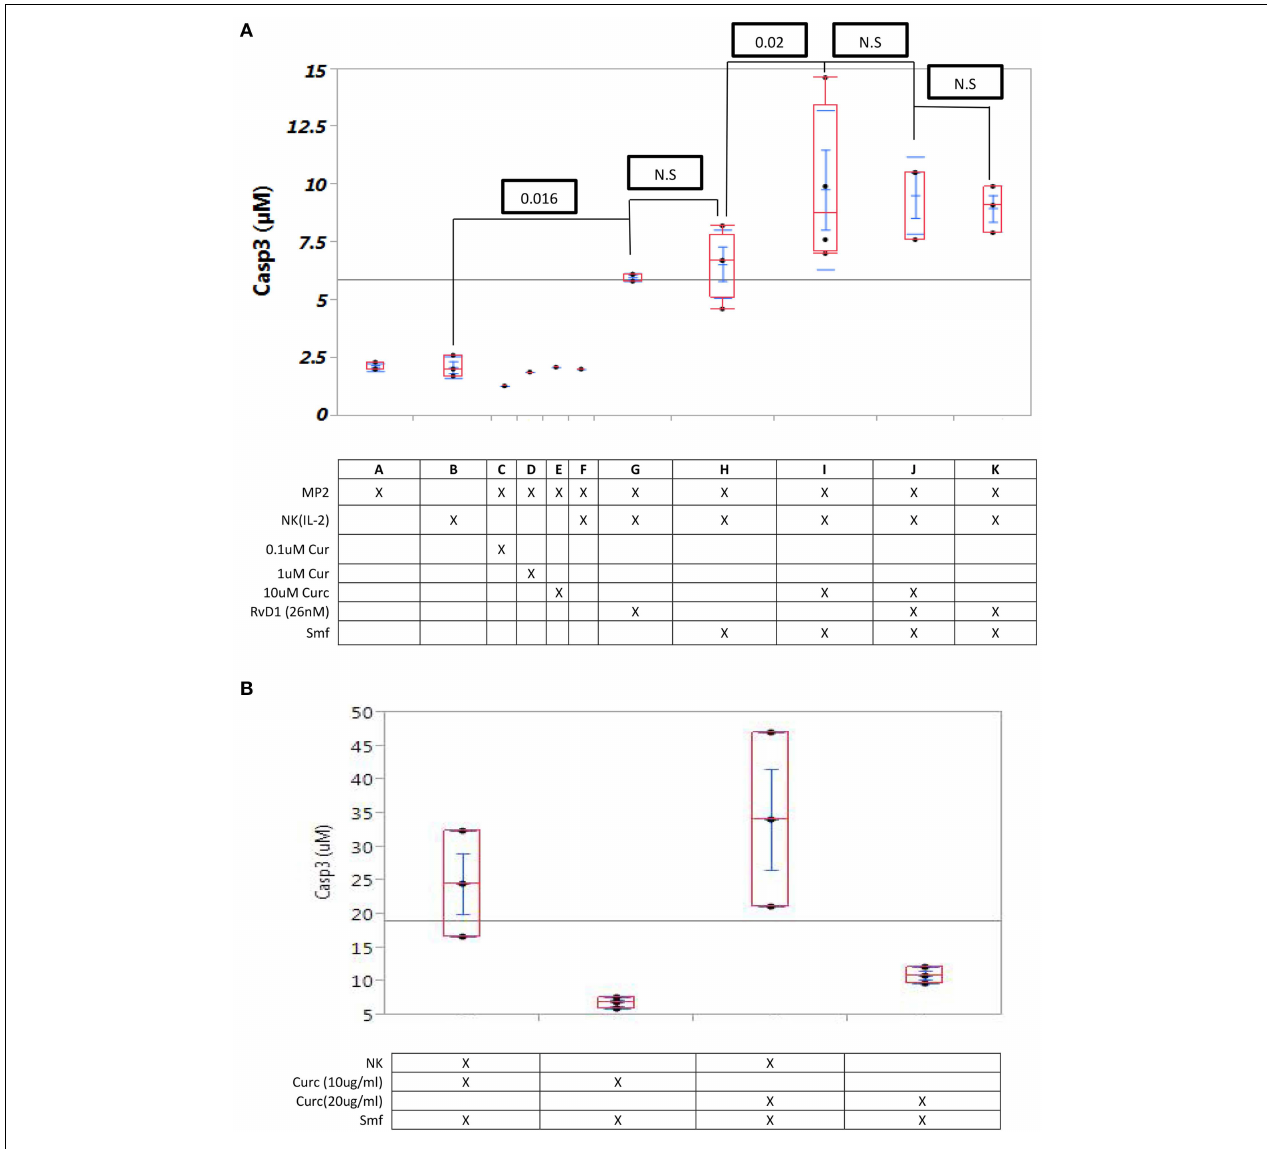
RvD1. (A–F) No caspase-3 induction by NK cells alone or curcuminoids alone; (G,H) low induction by NK cells with ω -3 or RvD1 (26nM) ( P = 0 . 016 ); (I–K) maximum induction by NK cells with ω -3or RvD1 ( P = 0 . 02 ). ( B) Comparison of caspase-3 induction by curcuminoids and smartfish with or without NK